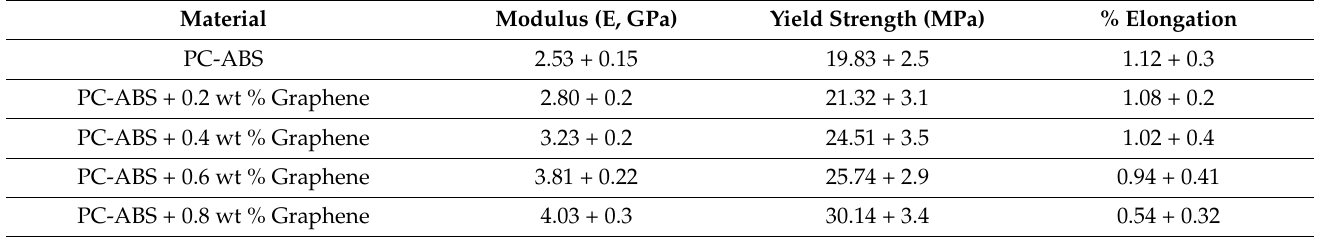
Table 2. Modulus, yield strength, and % elongation of PC-ABS and its composites.